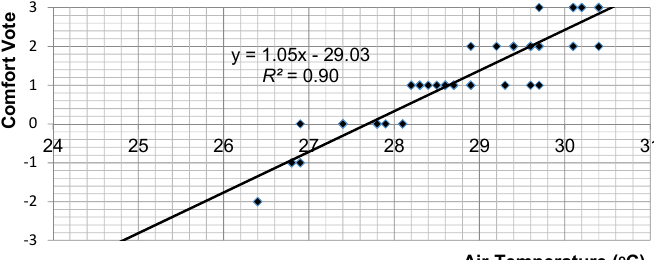
Figure 4. Regression line of thermal sensation vote on air temperature in the